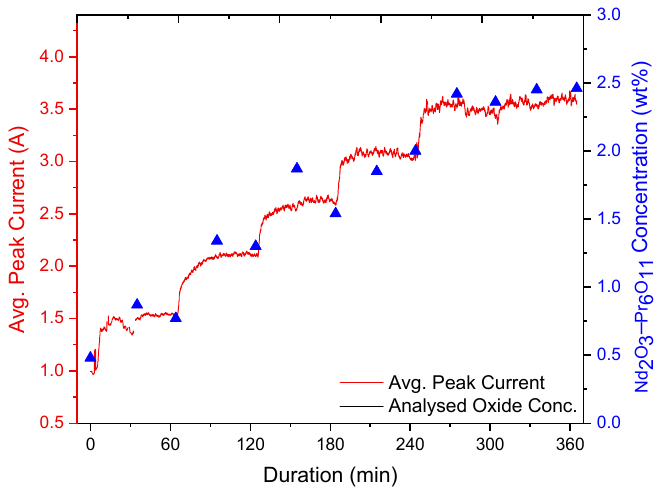
Figure 5. Data from the dissolution of a mixture of neodymium and praseodymium oxides (77.5 wt% Nd 2 O 3 –22.5 wt% Pr 6 O 11 ) in an equimolar NdF 3 –LiF